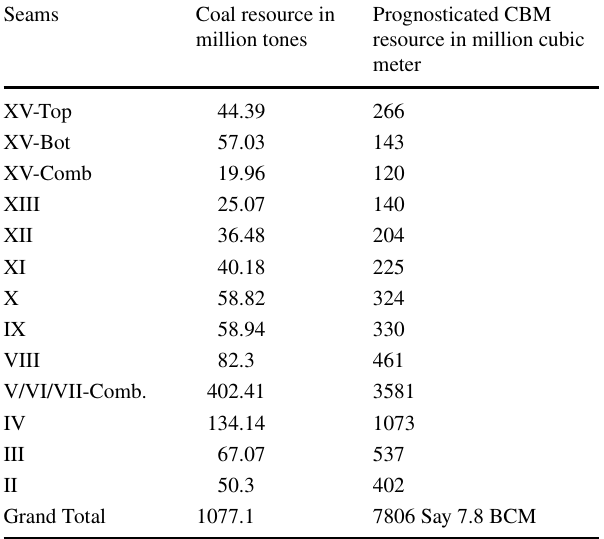
Table 1 Seam-wise estimated CBM in Moonidih coalfield (CMPDI